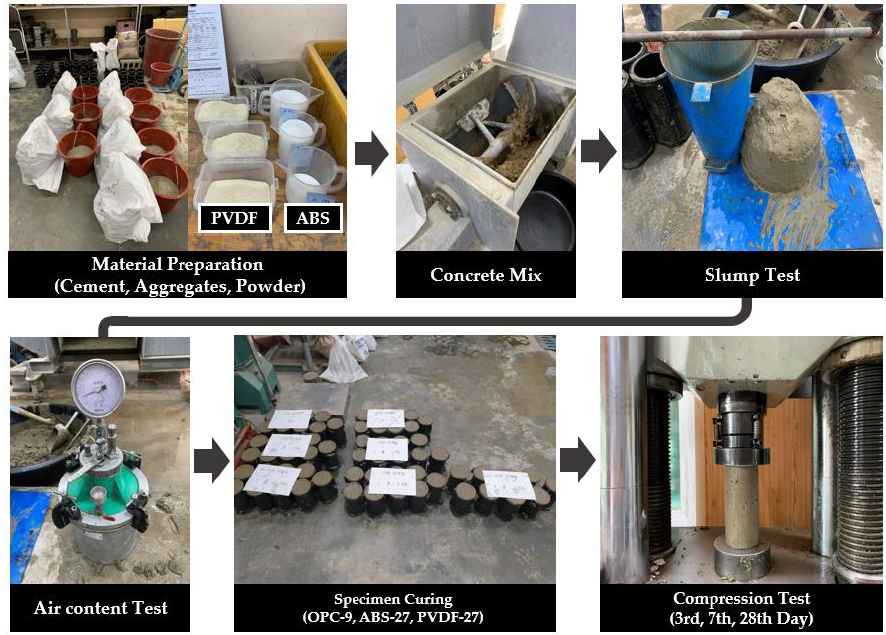
Figure 3. Testing process for ABS/PVDF concrete.